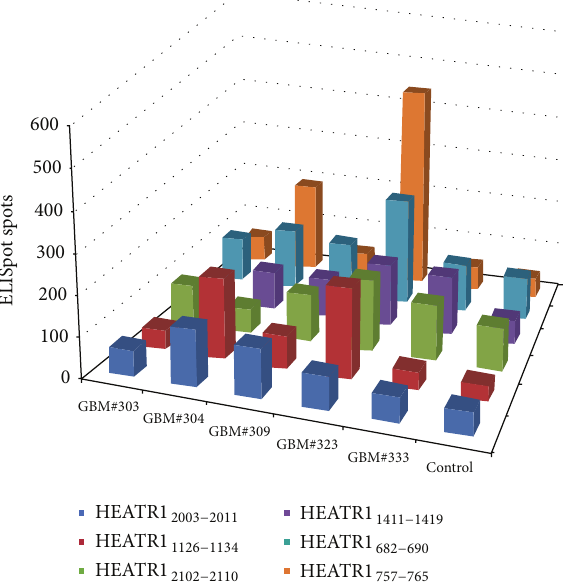
Figure 4: Single epitope peptide derived from the HEATR1 induces the IFN- 𝛾 response using ELISpot assay. PBMCs were extracted from 5 patients with HLA-A2+ GBM and 1 controlled patient with HLA-A ∗ 02+ benign tumor. IFN- 𝛾 formingspots were calculated per 1 × 10 6